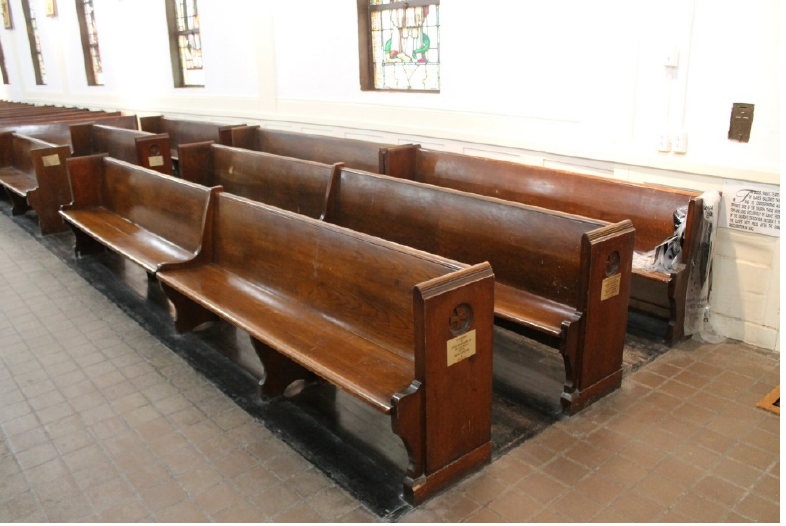
Figure 4. Pews reserved for the enslaved located in the nave of the Saint Augustine Catholic Church. Image by the author. June 2017.